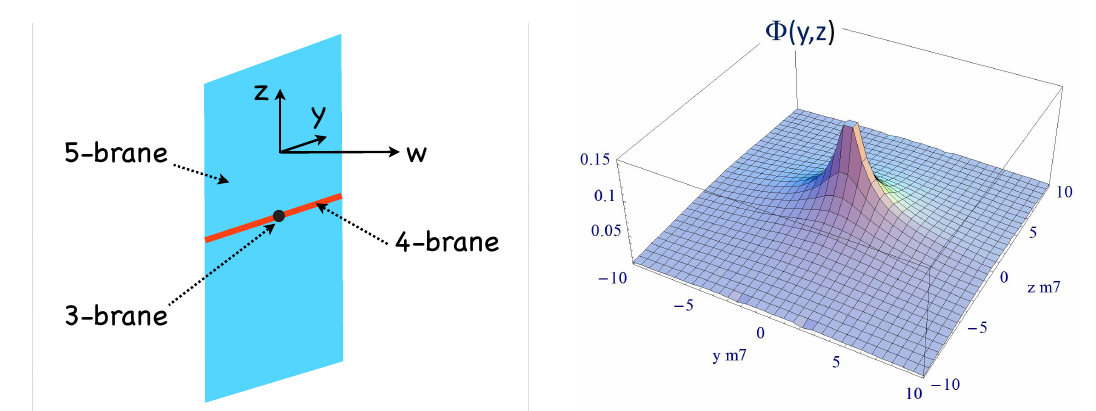
Figure 3: Seven-dimensional cascading scenario and solution for one the metric potential Φ on the (5+1)- dimensional brane in a 7-dimensional cascading gravity scenario with tension on the (3 + 1)-dimensional brane located at 𝑦 = 𝑧 = 0, in the case where 𝑀 4 6 /𝑀 3 5 = 𝑀 5 7 /𝑀 4 6 = 𝑚 7 . 𝑦 and 𝑧 represent the two extra dimensions on the (5 + 1)-dimensional brane. Image reproduced with permission from [149], copyright